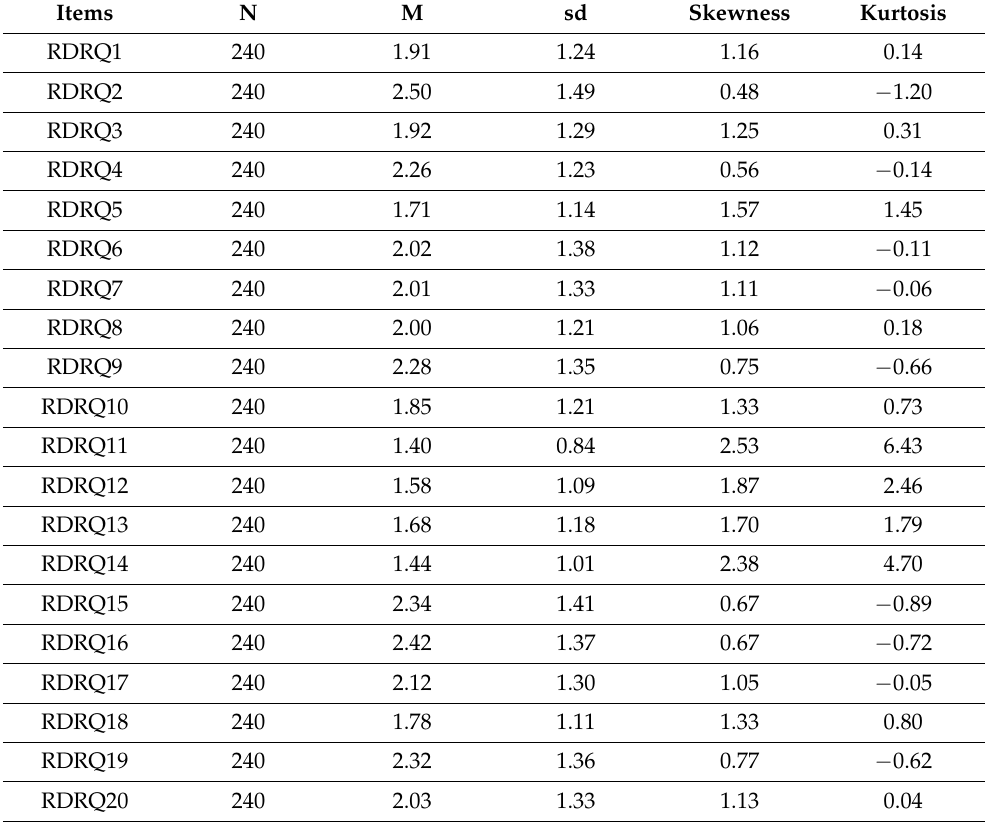
Table 1. RDRQ Item Means, Skewness, and